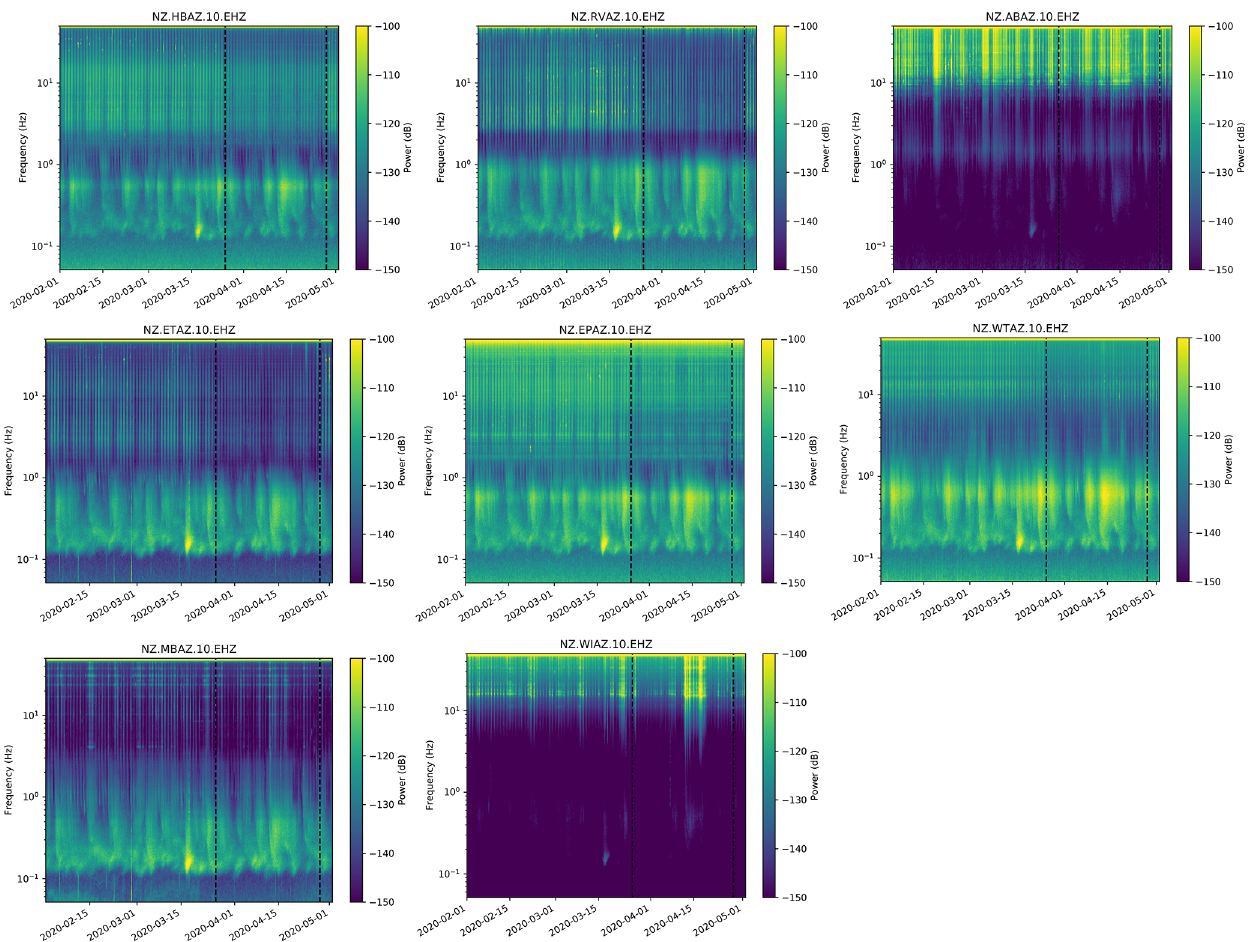
Figure A1. Spectrograms for the seismic data of the Auckland Volcanic Seismic Network. The vertical dashed lines indicate the start and end dates of the COVID-19 lockdown in New